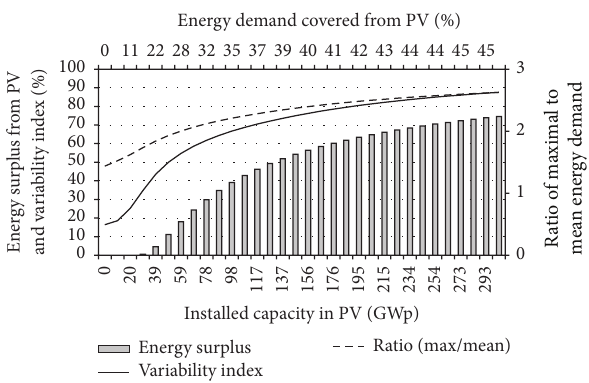
Figure 7: Photovoltaics impact on energy demand variability.